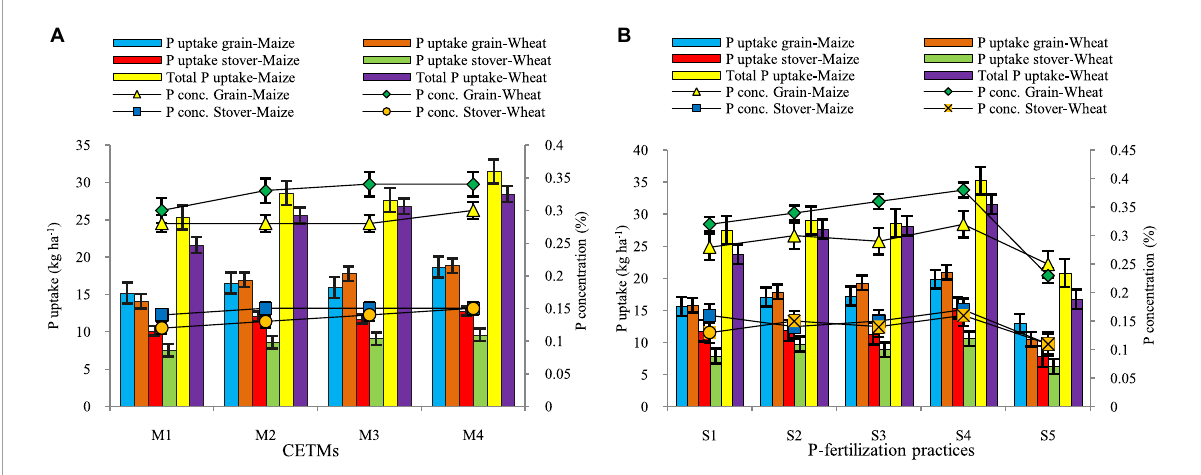
FIGURE7 Effect of crop establishment and tillage management (CETM) (A) and P-fertilization practices (B) on P content and P uptake in grains and stover and total P uptake in maize and wheat under MWCS (2-years’ av.). The vertical bars represent LSD 0 . 05 values . M 1 , flat bed–conventional tillage (FBCT) both in maize and wheat; M 2 , raised bed–CT (RBCT) in maize and RB–zero tillage (RBZT) in wheat; M 3 , FBZT both in maize and wheat; M 4 , permanent raised bed–ZT (PRBZT) both in maize and wheat. S 1 -P 100 , 100% P as basal; S 2 -P 50 + 2FSP, 50% P as basal (P 50 ) + 2 foliar sprays of phosphorus (2FSP) as DAP (2%) at knee-high stage (KHS) and pre-tasseling stage (PTS) in maize and at tillering stage (TS) and pre-flowering stage (PFS) in wheat; S 3 -P 50 + PSB + AM-fungi (AMF); S 4 -P 50 + PSB + AMF + 2FSP at KHS and PTS in maize and at TS and PFS in wheat; S 5 -P 0 , 100% N and K with no P (P 0 ) as